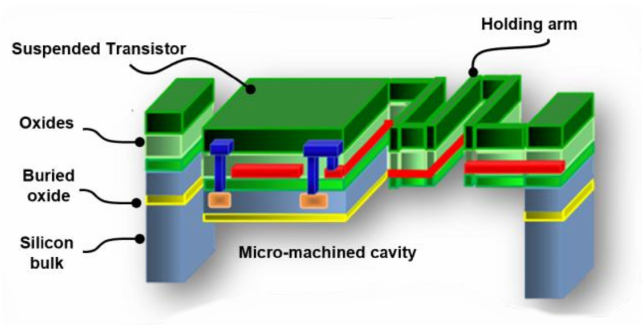
Figure 1. Schematic description of the TMOS.